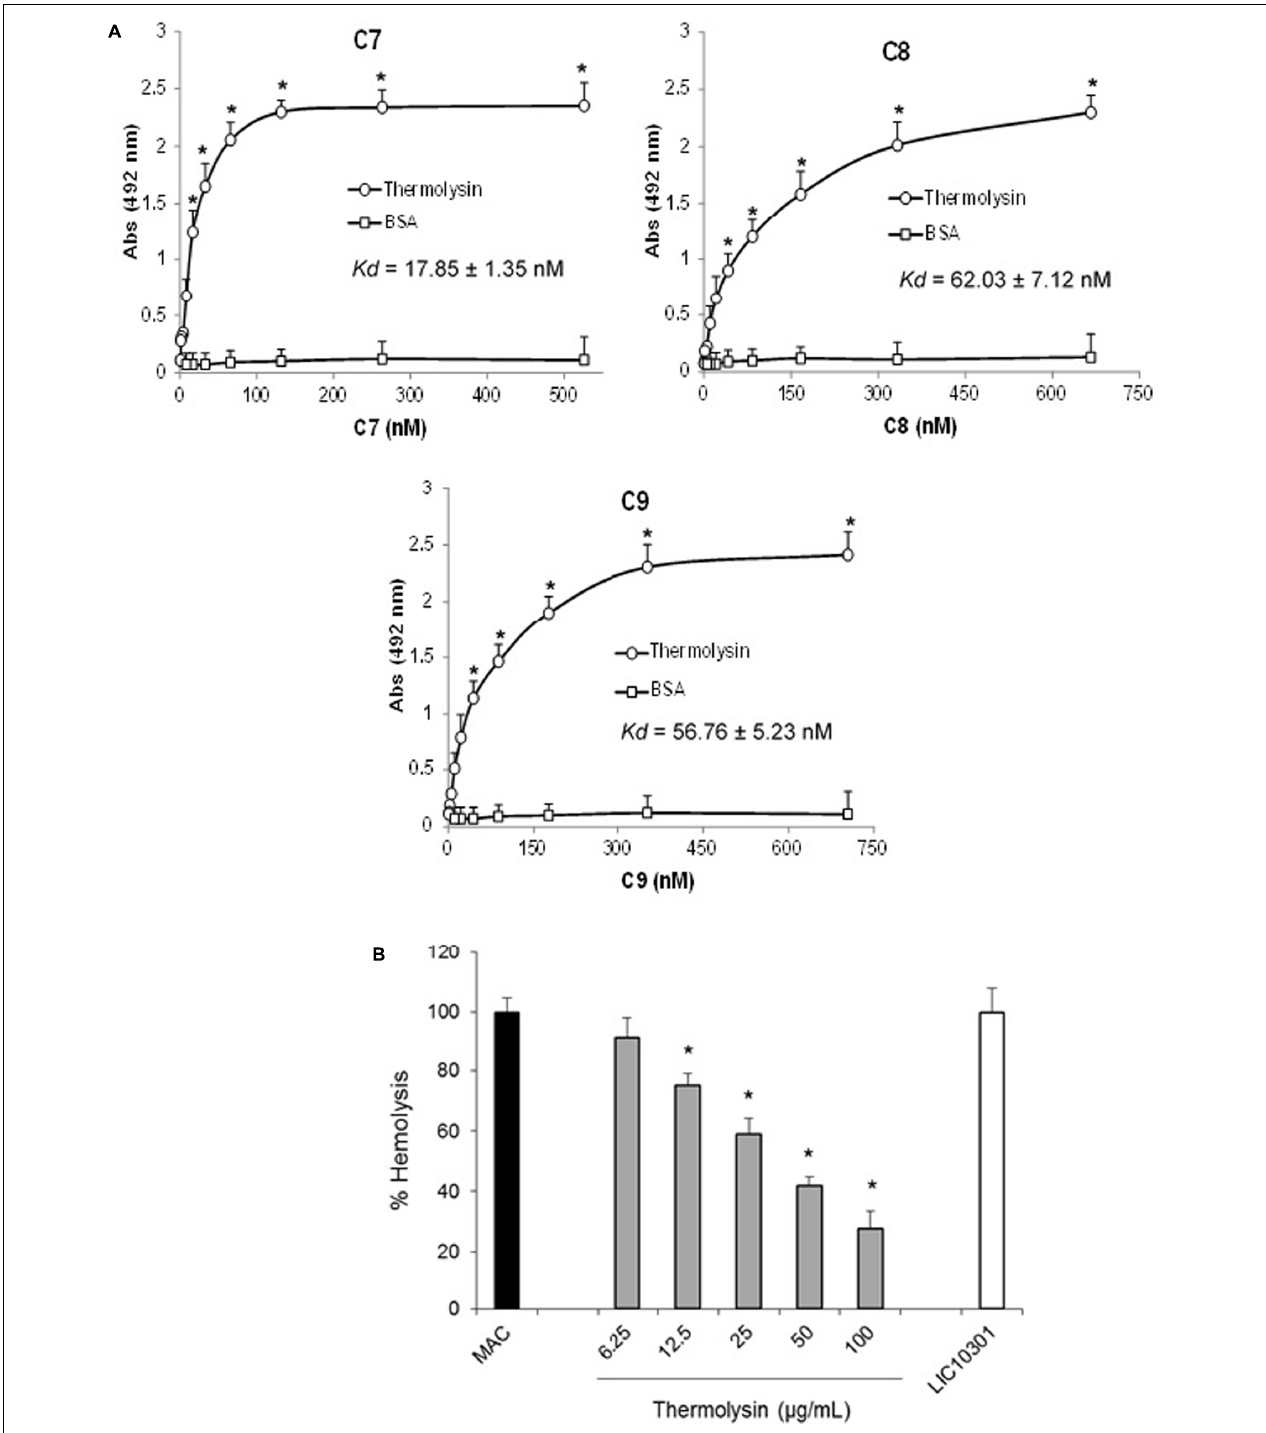
FIGURE 11 | Thermolysin inhibits MAC-mediated hemolysis. (A) Microtiter plates were coated with thermolysin (1 µ g) and different amounts of C7, C8, or C9 were added. Binding was detected with specific antibodies against the complement proteins. BSA was included as a negative control. Each point represents the mean absorbance value at 492 nm ± SD of three independent experiments, each performed in duplicate. Binding of MAC proteins to thermolysin was compared with the binding of these molecules to BSA by the two-tailed t -test ( ∗ P < 0.05). The dissociation constant ( K d ) of the interactions was calculated by fitting the data to the equation Y = B max ∗ X/(K d + X) using GraphPad Prism 5.0 (GraphPad Software, Inc.). (B) Thermolysin (6.25–50 µ g/ml) or LIC10301 (50 µ g/ml) were pre-incubated with C7, C8, and C9 and then added to C5b6-coated sheep erythrocytes. After incubation, cell lysis was measured, and the lysis in the absence of inhibitor (MAC) was set to 100%. Statistical analyses were performed using ANOVA. ∗ p ≤